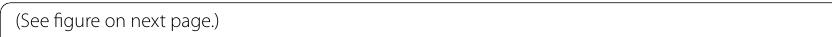
Fig. 3 Gene expression changes in SiMa and IMR-32 cell line differentiated for seven days. The mRNA expression was first normalized using GAPDH , TUBB3 , B2M , RPL13A and RPL19 for the SiMa cell line and GAPDH , HPRT , H3F3B and RPL19 for IMR-32 cells. Bar diagram over average relative mRNA expression level with error bars indicating standard error of the mean (SEM). Controls (open barn) set to 100% for